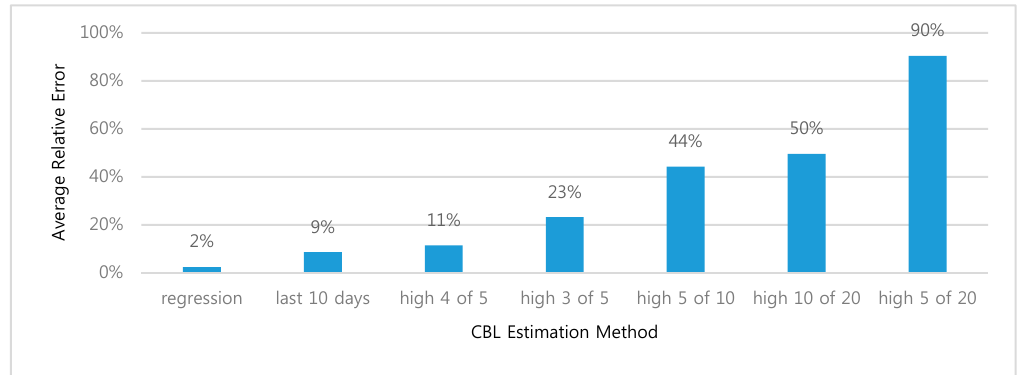
Figure 6. Average relative error for various CBL estimation methods.